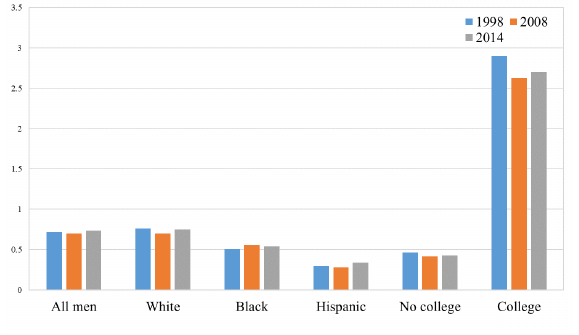
Figure 4: Ratio of density of ties between low-high and low-low occupational status occupations estimated using full valued networks for different sociodemographic groups, 1998 to 2014